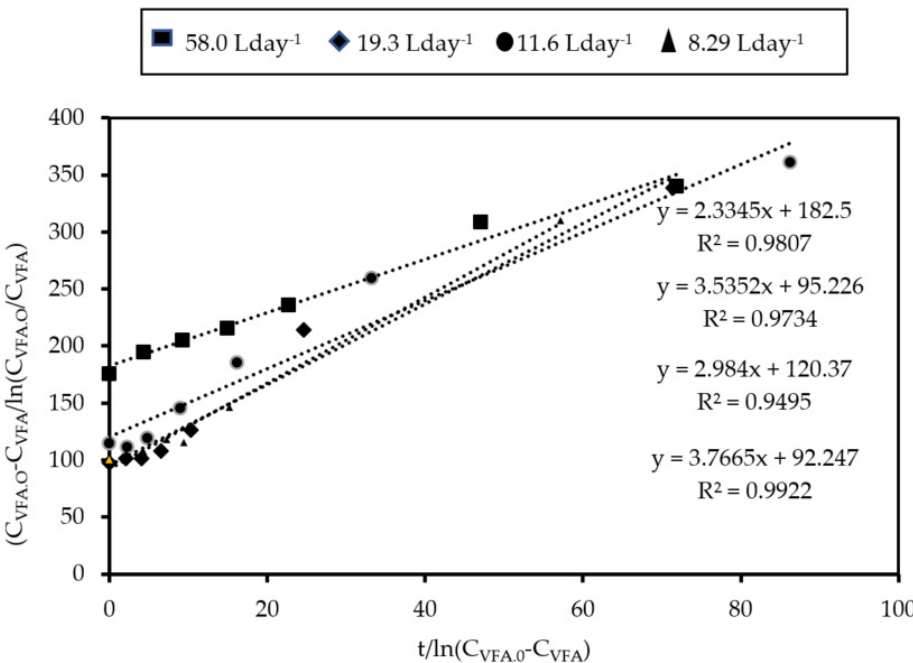
Figure 4. Determination of k max . VFA and k s . VFA by using the integral method. Table 3. Kinetic constant of the Monod model and the integral method for syntrophic acetogenesis.